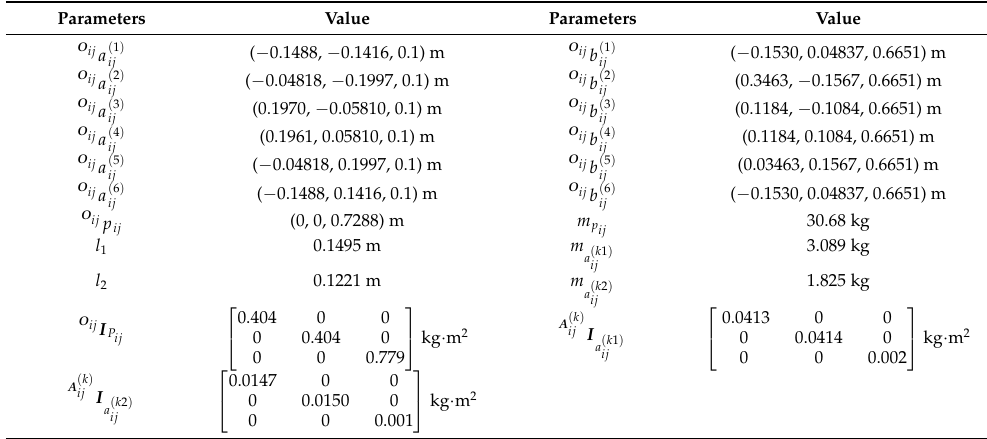
Figure 4. Dynamics model in ADAMS. Table 1. Module unit parameters.